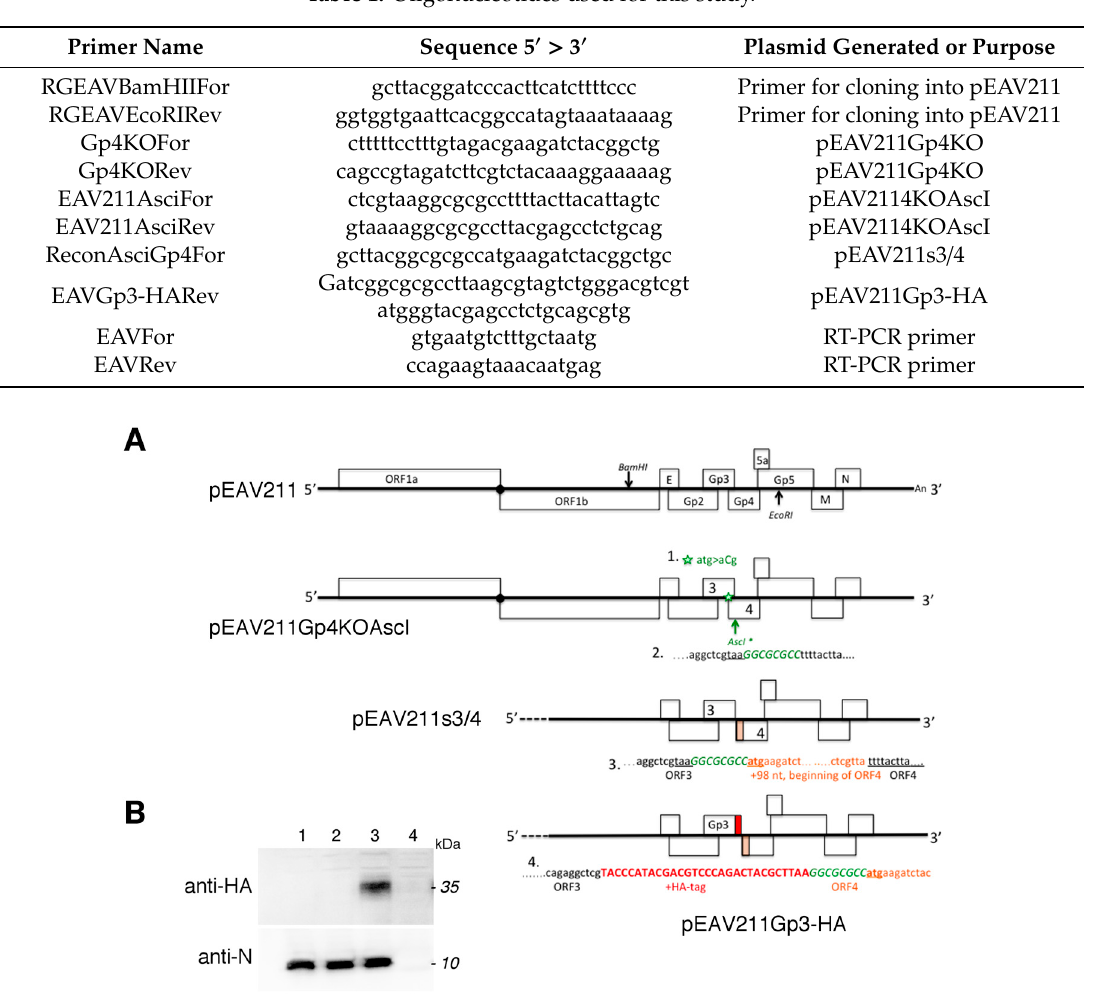
Table 1. Oligonucleotides used for this study.